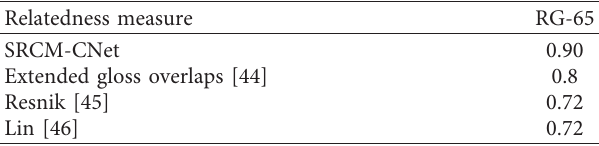
Table 10: Spearman’s rank correlation coefficient with